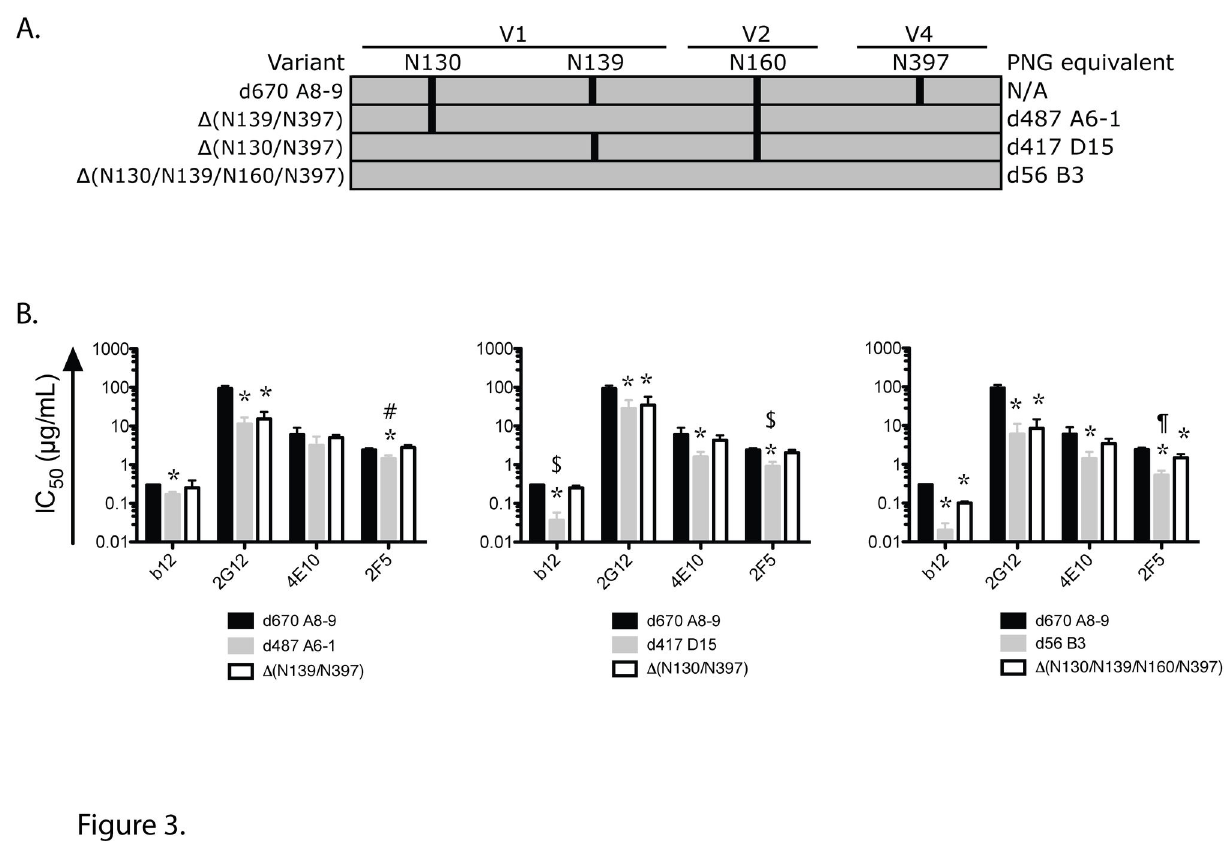
Figure 3. Specific PNGS affect heterologous neutralization. ( A ) Cartoon depicting PNGS profiles of A141 Env mutants. The mutants are indicated on the left and the corresponding PNG equivalent A141 clones are indicated on the right. Vertical bars indicate the presence of a PNGS at the amino acid positions (130, 139, 160 or 397) shown. ( B ) Serially diluted monoclonal antibodies (b12, 2G12, 4E10 and 2F5) were tested for the neutralization of the pseudovirus of interest [d56 B3, d417 D15, d487 A6-1 and d670 A8-9] or of the PNG mutant of interest [Δ(N130/397), Δ(N139/397) and Δ(N130/139/160/397)] in a TZM-bl cell assay. The MAb concentration (µg/mL) required to reach 50% neutralization of each pseudovirus is reported as IC are mean +/- SD from three independent assays. P < 0.02 compared to d670 A8-9. # P = 0.0003 compared to d487 A6-1. $ P ≤ 0.0006 compared to d417 D15. ¶ P = 0.0042 compared to d56